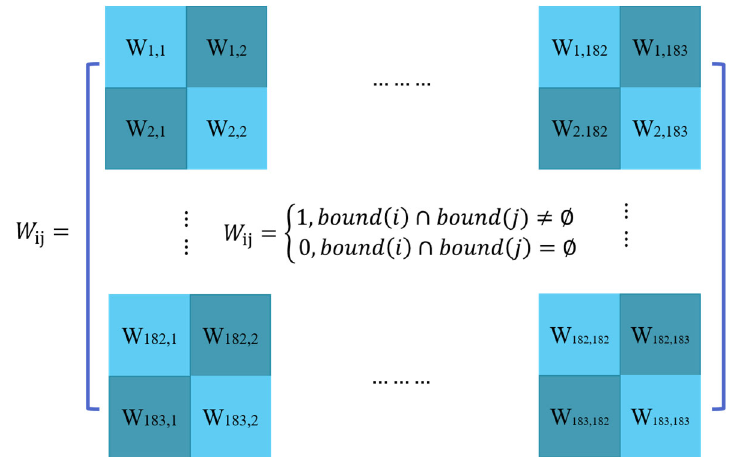
Figure 2. The spatial weight